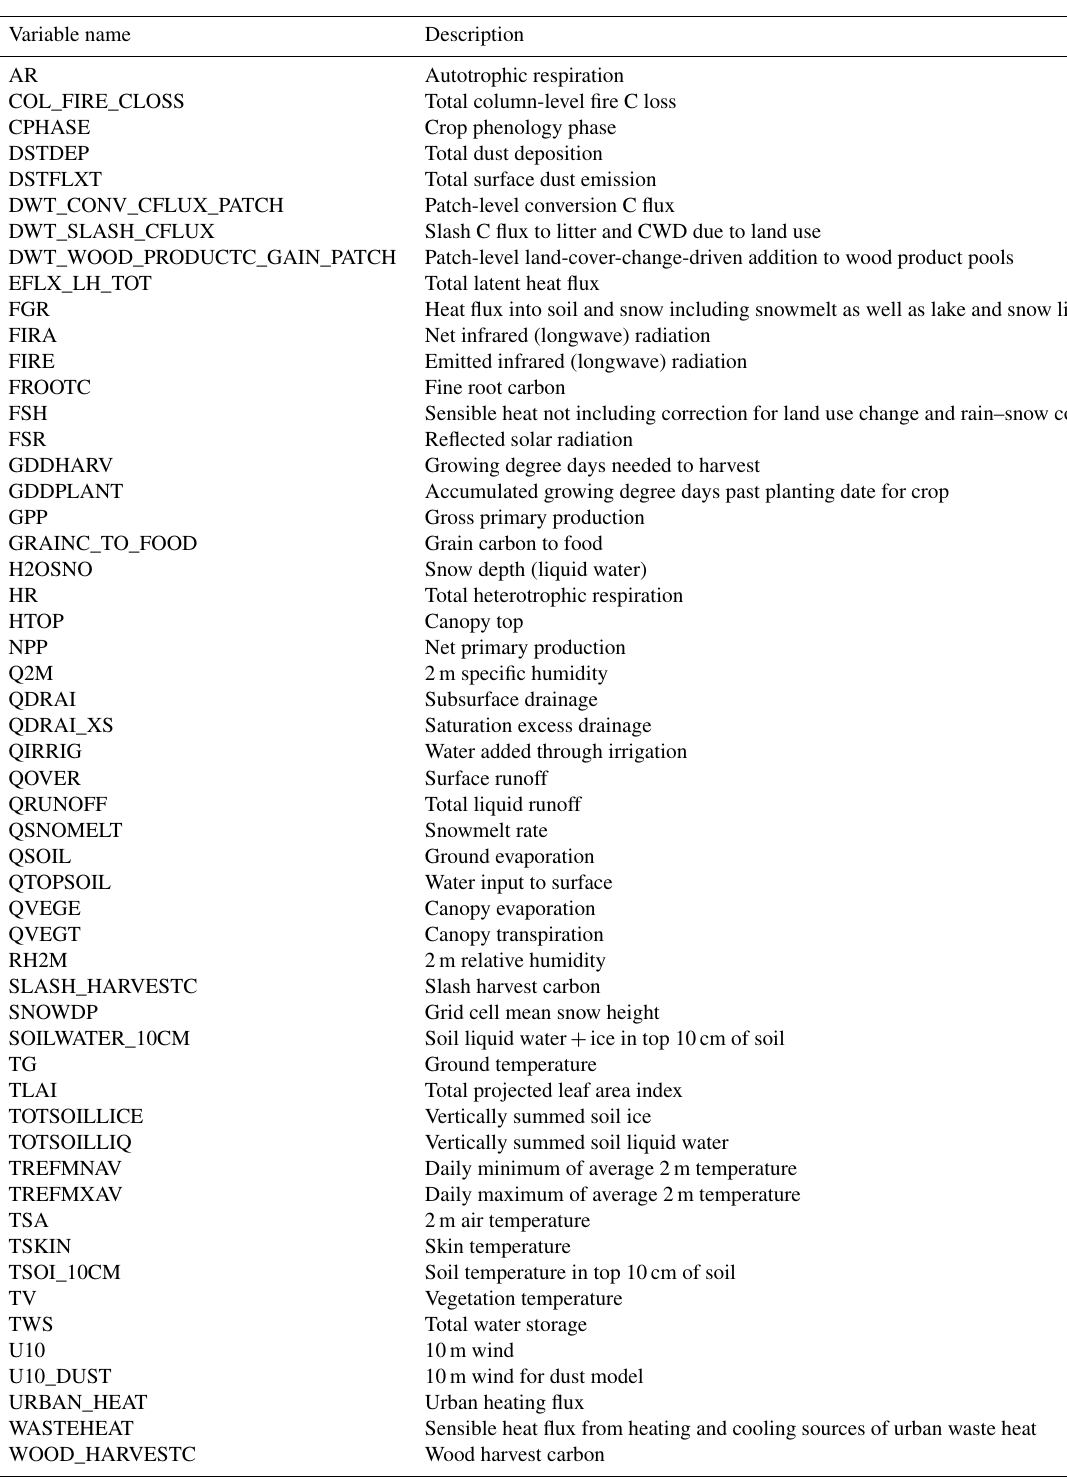
Table A6. Available daily averaged output from the land model at land unit level in ARISE-SAI-1.5 simulations and five additional SSP2–4.5 CESM2(WACCM6) simulations. None of the above output is contained in the first five ensemble members of CESM2(WACCM6) SSP2–4.5